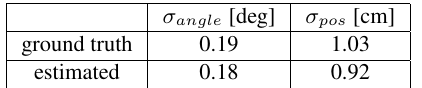
Table 2. Comparison between the estimated (internal) uncertainty and the uncertainty obtained by the ground truth